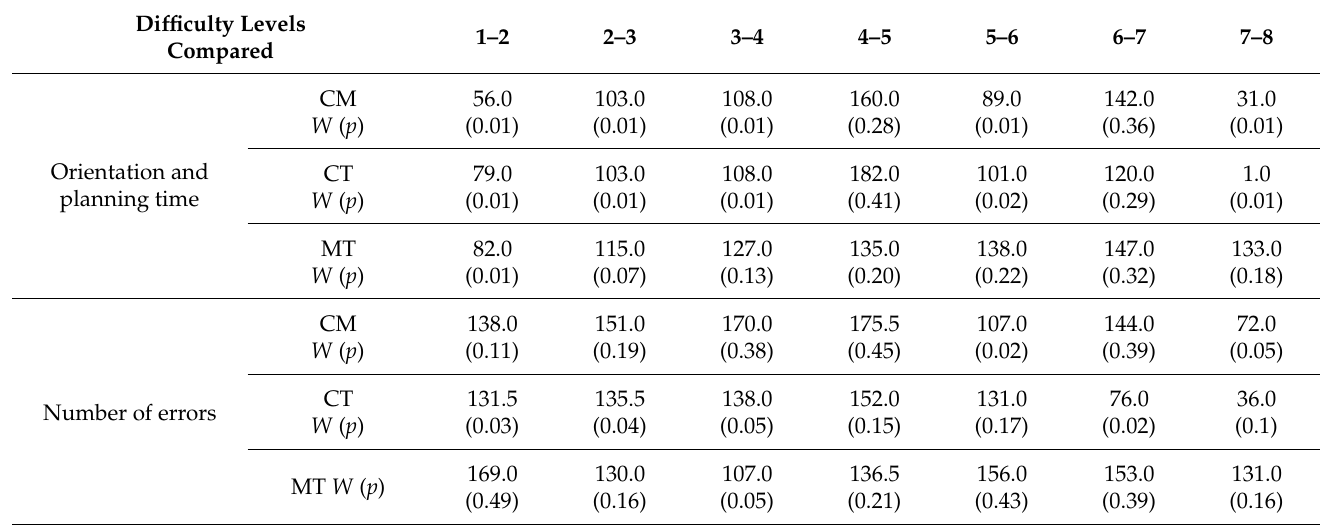
Table 3. Orientation and planning time and the number of errors comparison between different difficulty levels in all